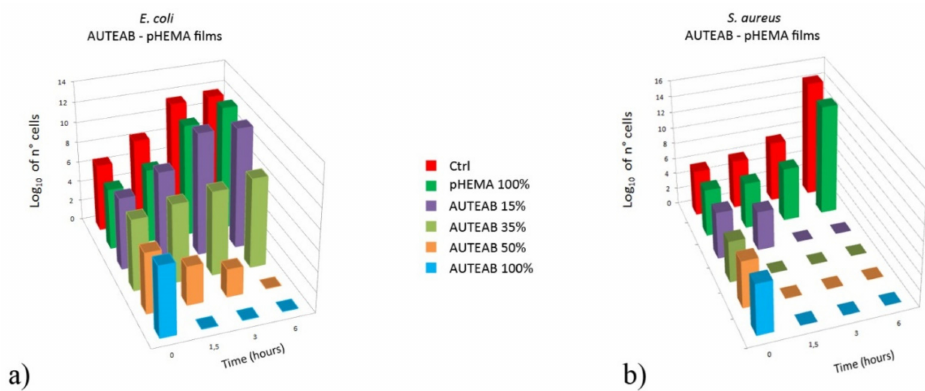
Figure 4. Comparison of viable cell number of E. coli TG1 ( a ) and S. aureus ( b ) as a function of time in the presence of control (no film, red histogram), blank reference (pHEMA, dark green histogram), 15% AUTEAB film (purple histogram), 35% AUTEAB film (light green histogram), 50% AUTEAB film (orange histogram) and 100% AUTEAB film (light blue histogram). Bacteria cells were grown in Luria-Bertani broth and the cell number was determined by surface spread plate technique, as described in the Materials and Methods Section.